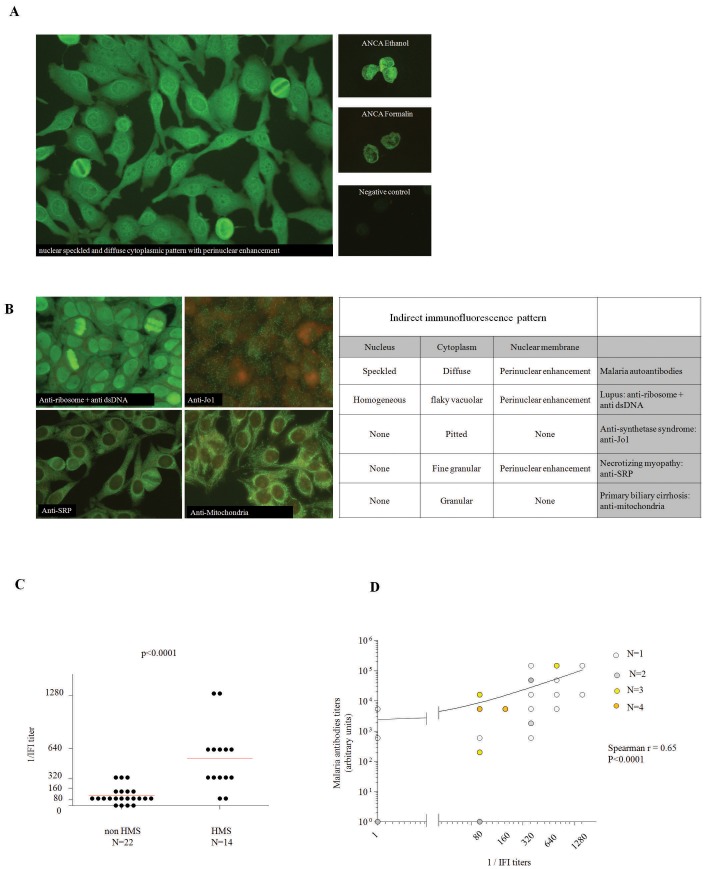
Distinct immunofluorescence pattern on HEp-2000™ cells detected in the serum of patients with malaria.
A Nuclear speckled and cytoplasmic diffuse pattern with perinuclear enhancement detected by indirect immunofluoresence on HEp-2000™ cells (left) and on human neutrophils fixed with ethanol (top right) with the serum of a patient with HMS. Cytoplasmic diffuse pattern with perinuclear enhancement on neutrophils fixed with formalin. The nuclear speckled pattern is faded as observed with usual antinuclear antibodies (right middle). Negative control for ANCA testing (right bottom). B Common immunofluorescence patterns with cytoplasmic fluorescence that are diagnostic for SLE (anti-ribosome+anti-DNA), anti-synthetase syndrome (Anti-Jo1), necrotizing myopathies (anti-SRP) and primary biliary cirrhosis (anti-mitochondria) (left) compared with the distinct immunofluorescence pattern observed with malaria autoantibodies (right). C titers of autoantibodies with the distinct nucleo-cytoplasmasmic pattern in patients with HMS (n = 14) or non-HMS malaria (n = 22). Comparison performed using a U Mann-Whitney non parametric test. D Correlation of the titers of anti-malarial antibodies with the titers of autoantibodies with the distinct nucleo-cytoplasmic pattern. Correlation assessed using a Spearman non parametric test.